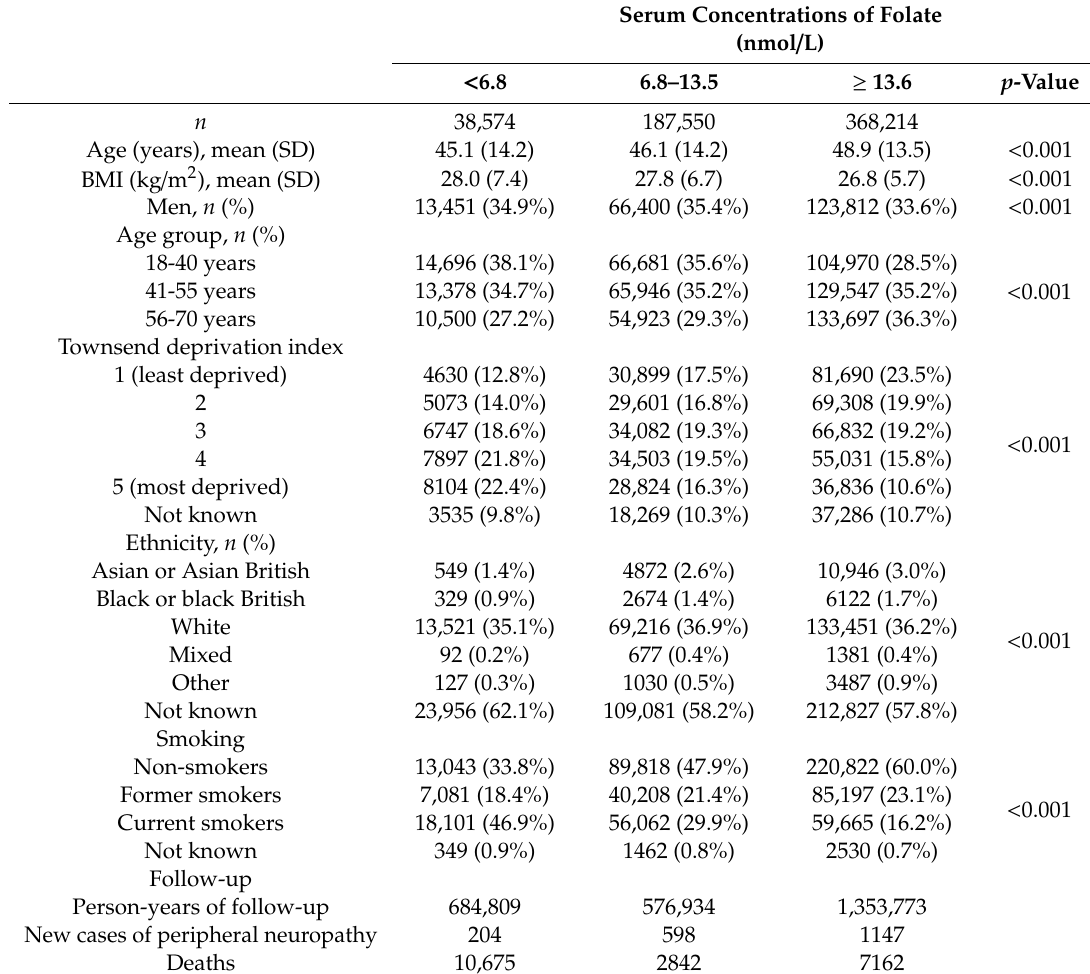
Table 1. Characteristics of THIN patients according to categories of serum concentrations of